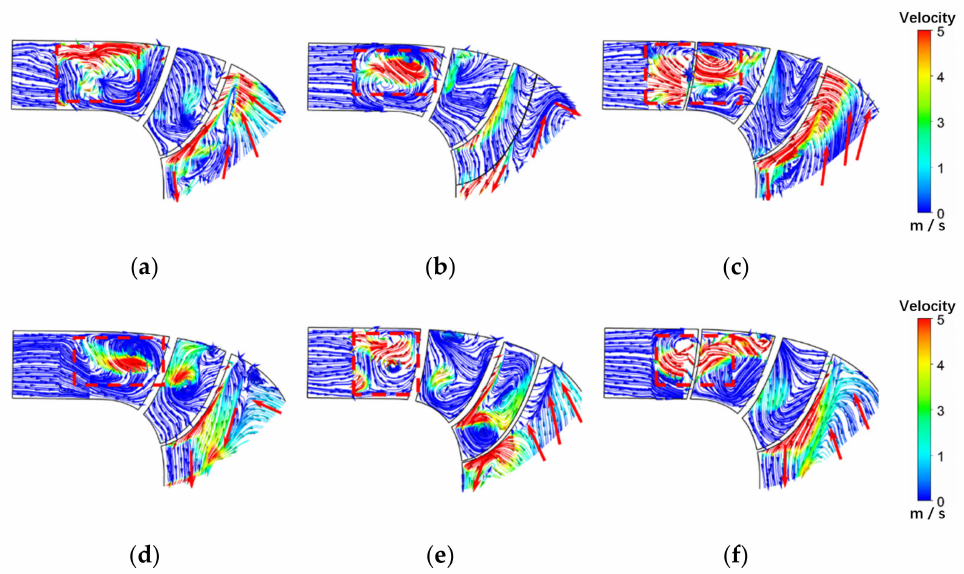
Figure 16. Flow pattern evolutions on a vertical section during the regulating period in Case2. ( a ) t = 42 s; ( b ) t = 48 s; ( c ) t = 55 s; ( d ) t = 61 s; ( e ) t = 68 s; and ( f ) t = 75 s.